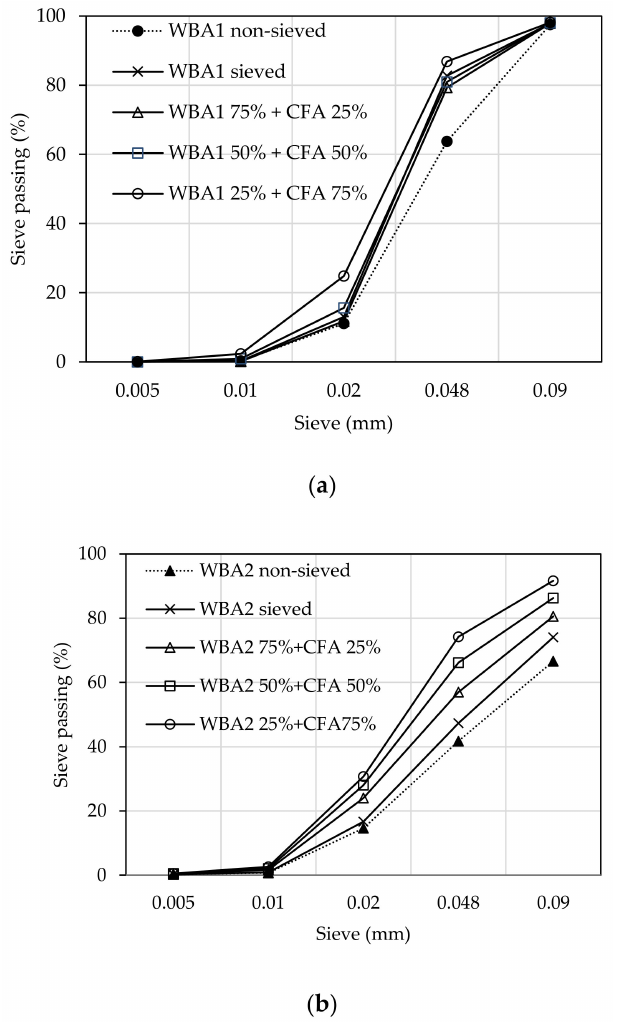
Figure 4. Particle size distribution of; ( a ) binders with WBA1; ( b ) binders with WBA2. In a hydrated lime (HL), the free water is the moisture bound to the lime